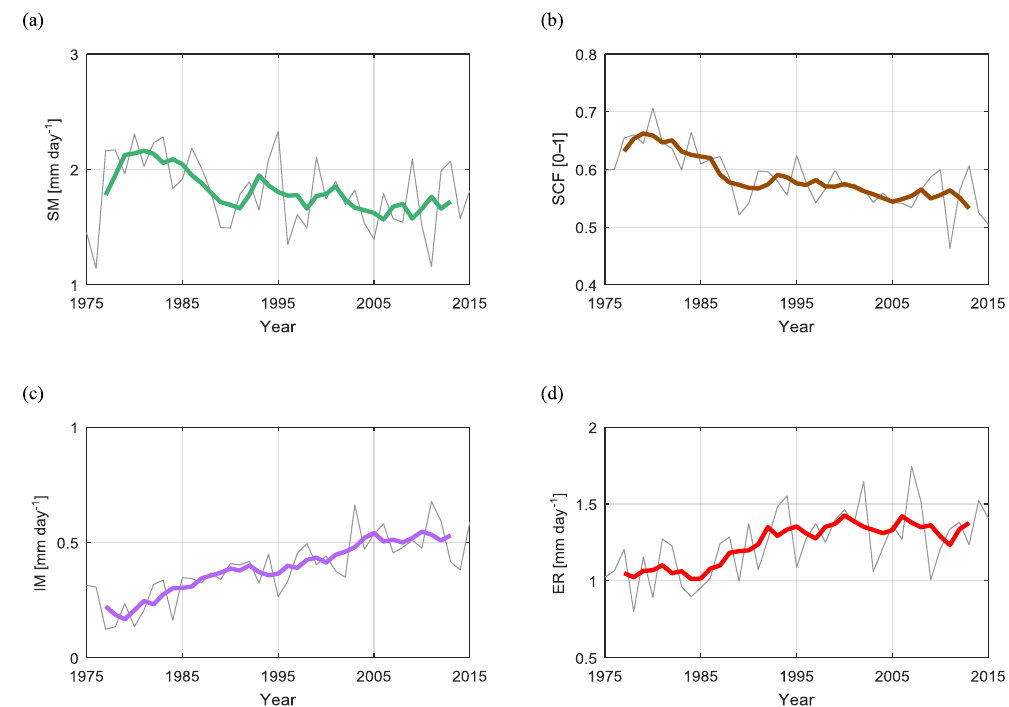
Figure 8. Simulations for the period 1975–2015 of mean annual variables: (a) snowmelt SM, (b) snow-cover fraction SCF, (c) ice melt IM, and (d) effective rainfall ER. Mean annual values are shown in grey and a 5-year moving average is shown with a thick